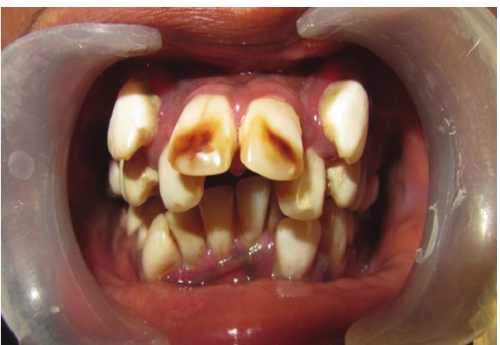
Figure 4: Severe crowding in upper and lower anteriors with fluorosis.